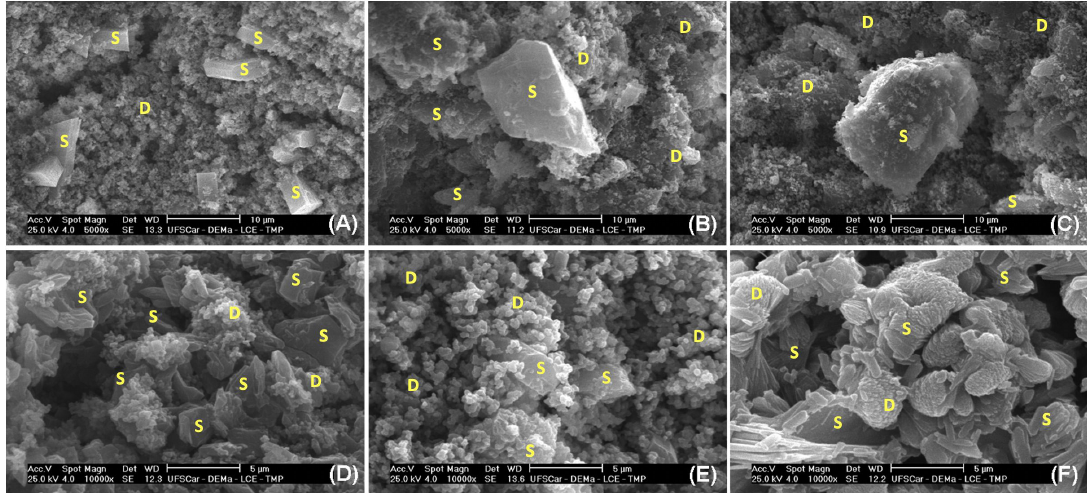
O; (B) C_01 – 60% H 2 O prepared using MgO powders calcined at 900 ºC / 2 h. (Struvite phase – S; dittmarite 2